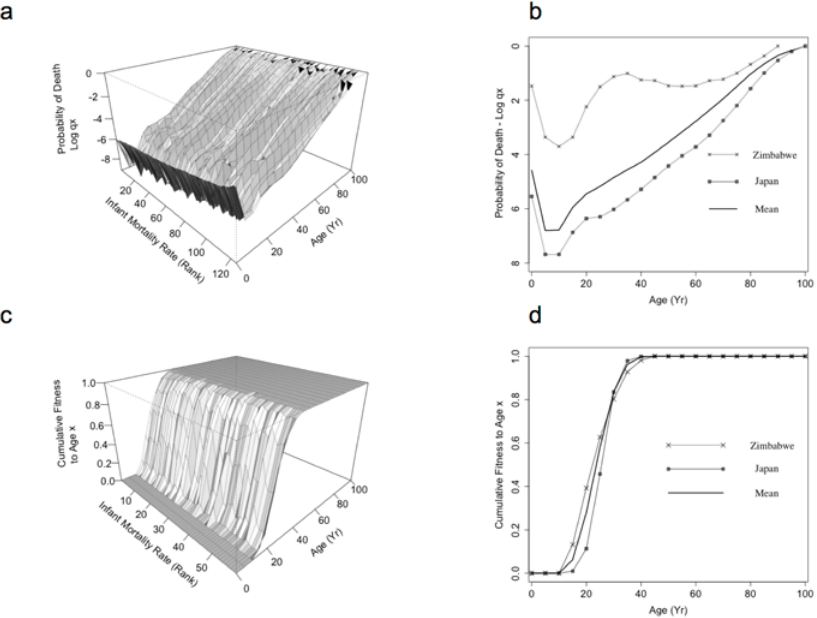
Figure 1. Variation in age-specific mortality and the accumulation of direct fitness. (a) Age-specific mortality profiles for populations in the most populous 132 nations (the UN Populations), ranked by infant mortality rate. (b) Range of human age-specific mortality profiles across countries with the lowest (Japan) and highest mortality rate (Zimbabwe; during a nation-wide cholera epidemic). (c) Accumulation of direct fitness with age, estimated using the Euler-Lotka equation for females in the 59 UN populations with available data. (d) Range of direct fitness accumulation across the life-course, measured by the